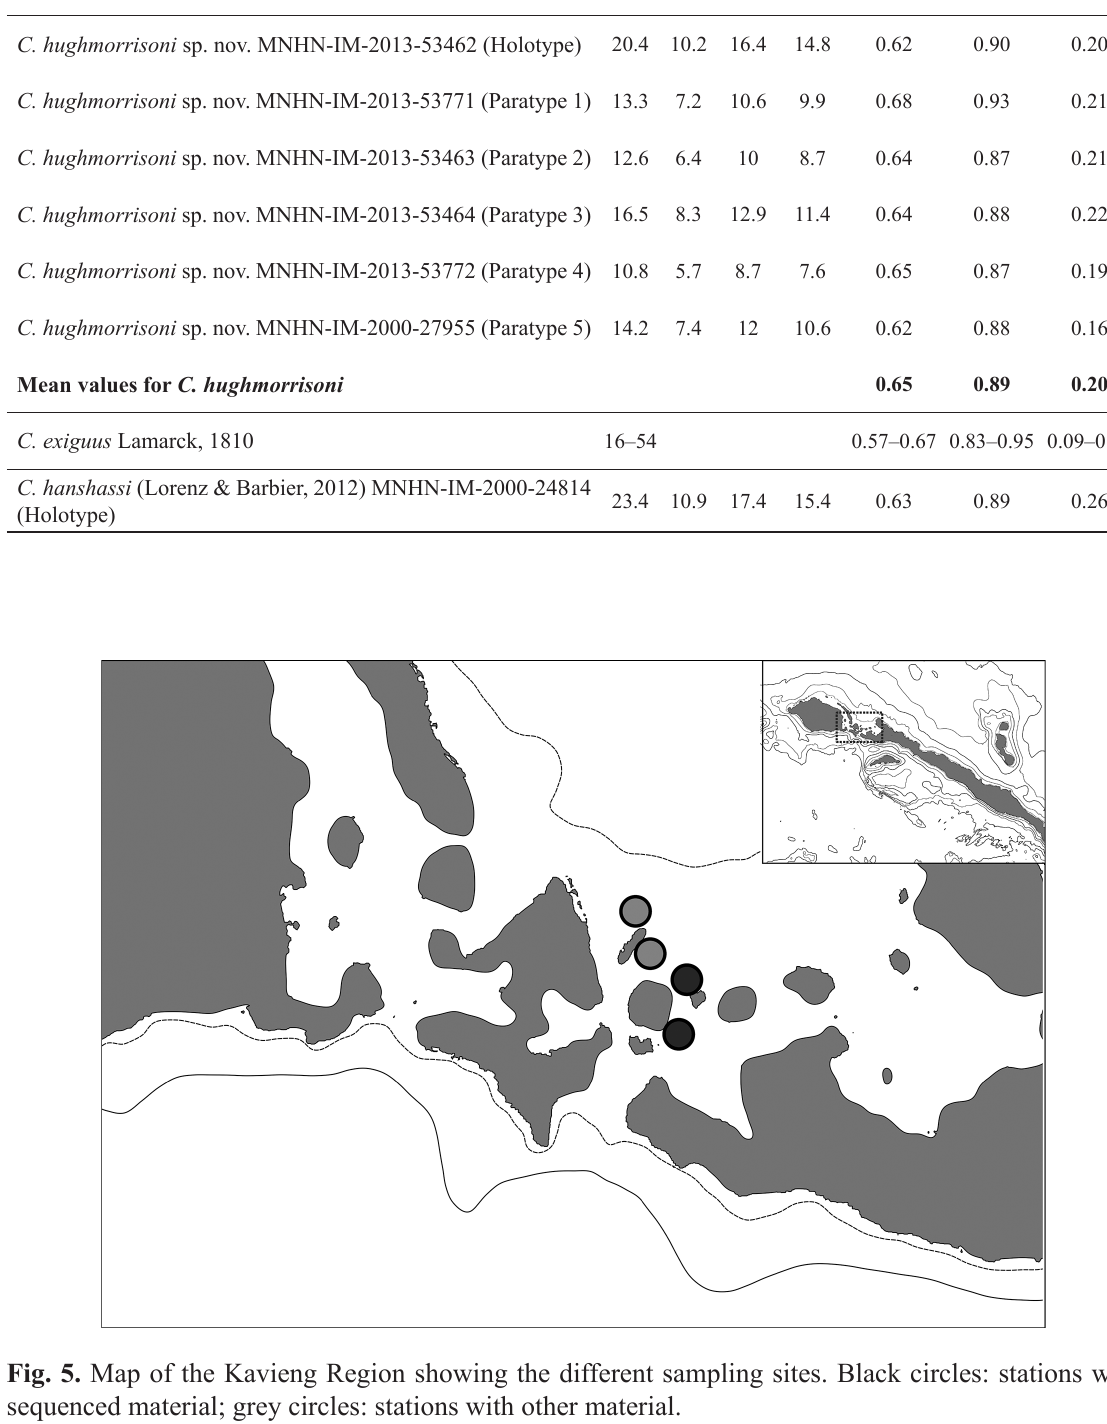
Table 2. Measurements (in mm) of shells of Conus hughmorrisoni sp. nov., Conus exiguus Lamarck, 1810 (taken from Röckel et al. 1995) and Conus hanshassi (Lorenz & Barbier, 2012). L = shell length; MD = maximum diameter; AH = aperture height; HMD = height of maximum diameter; RD = relative diameter of last whorl (MD/AH); PMD = position of maximum diameter of last whorl (HMD/AH); RSH = relative spire height ((L-AH)/L). L MD AH HMD RD PMD RSH